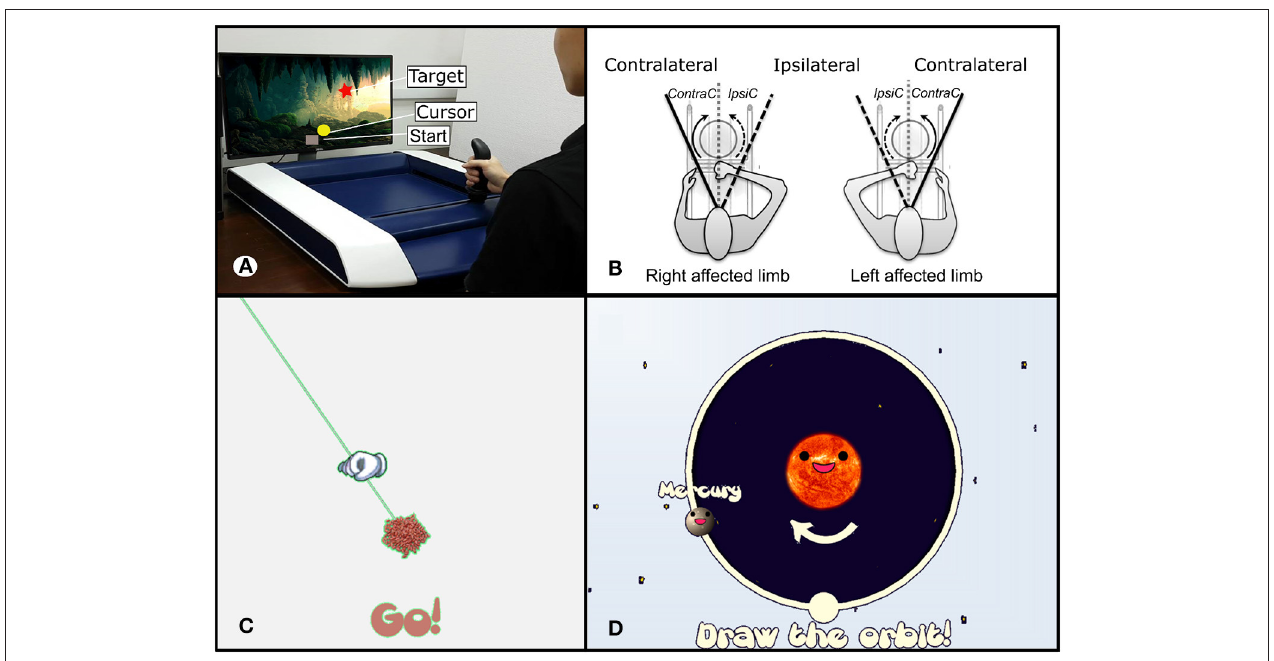
FIGURE 2 | (A) Subject using the latest version of H-Man, a novel and compact upper limb rehabilitation and assessment robot. (B) Representation of the assessment task protocols for subjects using the left and the right hand, with direction notations. (C) Representation of the visual stimuli used for the line tracing task. (D) Visual stimuli of the circle tracing task.